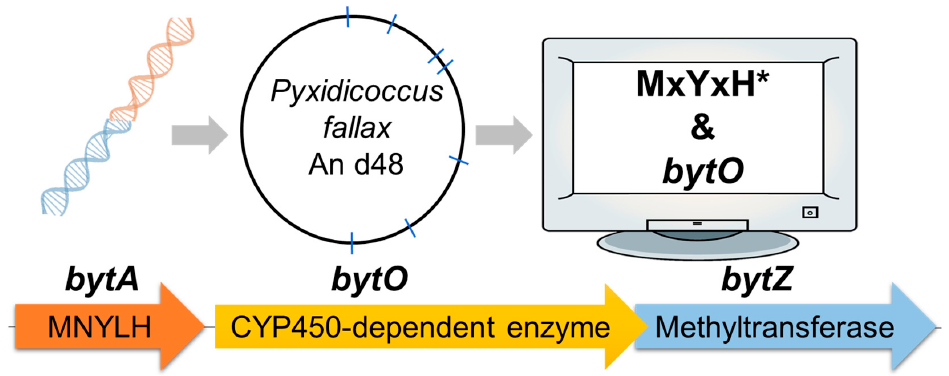
Figure 2. A genome-wide investigation in our in-house genome library, using the amino acid sequence MxYxH* (the asterisk represents a stop codon) and the DNA sequence of bytO homolog from Pyxidicoccus sp. CA032A as query, revealed a genetic operon in Pyxidicoccus fallax An d48, which comprises the gene bytA , encoding the pentapeptide MNYLH, bytO , encoding a cytochrome P450 (CYP450)-dependent enzyme and bytZ , which encodes an S -adenosyl-methionine-(SAM)-dependent methyltransferase .